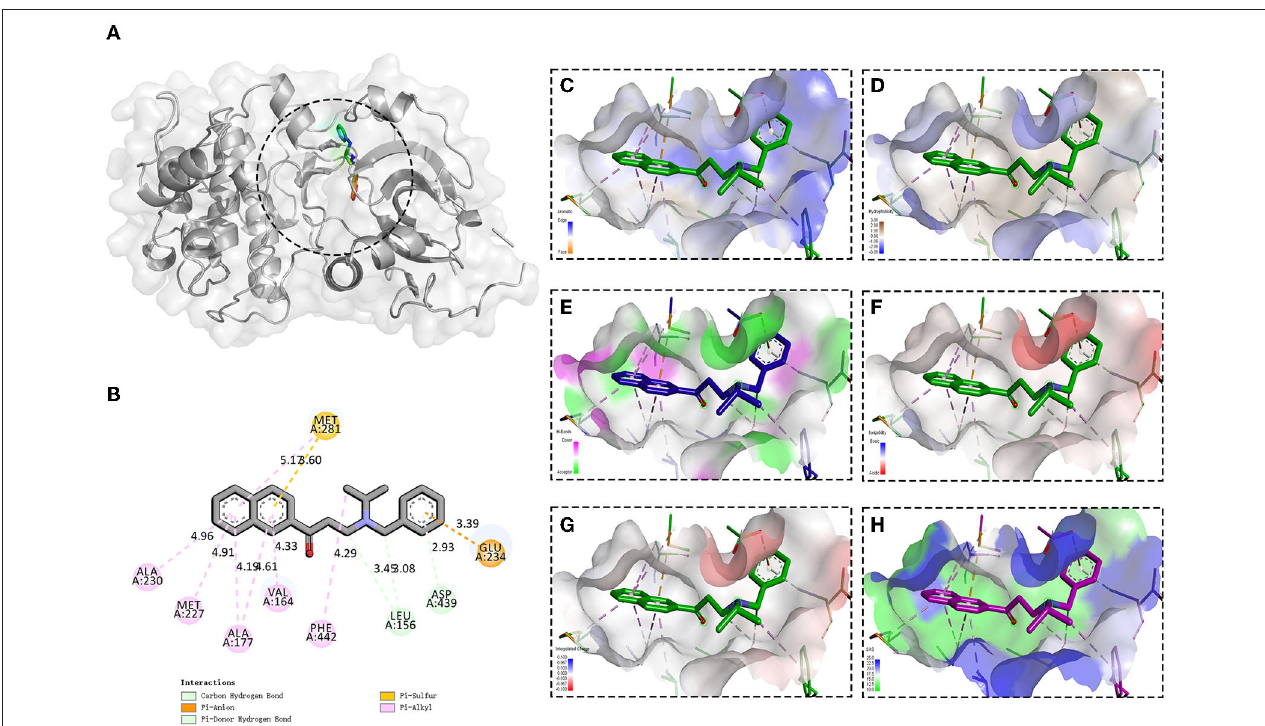
FIGURE 6 | Binding site and model of compound 8G1 with AKT. (A) Overview of the docked pose between the compound 8G1 and binding pocket to the active site of Akt. (B) The close view of the interaction between compound 8G1 and the active site of Akt. (C) The analyzed result of the aromatic ring edges or faces. (D) The analyzed result of the hydrophobicity. (E) The analyzed result of the hydrogen bond. (F) The analyzed result of the ionizability. (G) The analyzed result of the atomic charge, values less than − 0.1 are mapped in red, and values larger than + 0.1 are mapped in blue. (H) The analyzed result of the solvent accessibility surface, small values (green) correspond to buried residues, whereas large values (blue) correspond to exposed